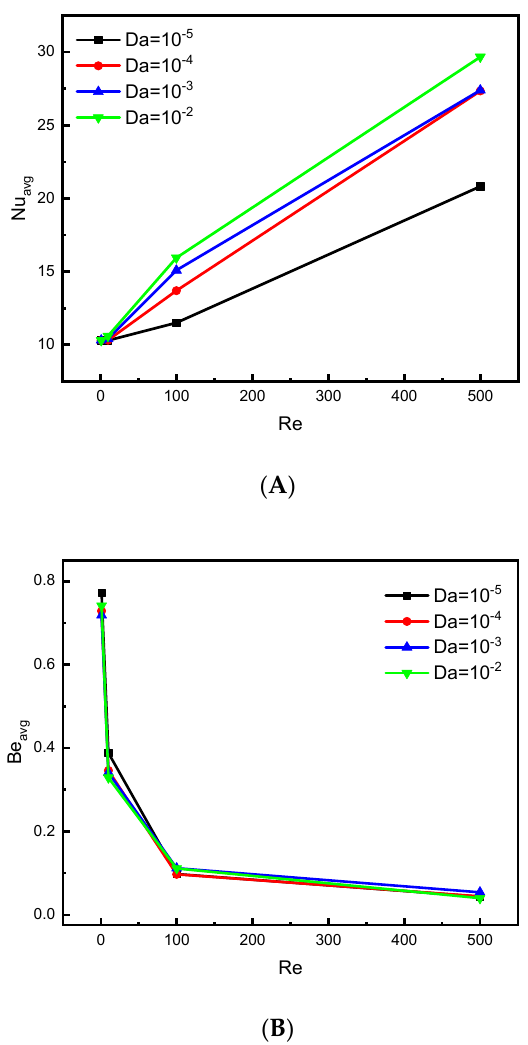
φ= Figure 8. Effect of Da on ( A ) Nu avg and ( B ) Be avg for 0.04 and Ha = 0. Figure 8. Effect of Da on ( A ) Nu avg and ( B ) Be avg for φ = 0.04 and Ha = 0. Figure 9A,B presents the influence of the number of lower wall zigzags on the average values of the Nusselt number (Nu) and Bejan number (Be) for Ha = 0 and Da = 10 − 2 . The number of zigzags in the bottom wall of the container changes the course of flow, which affects the heat transfer and total entropy generation. Figure 9A proves that the Reynolds number positively affects the Nusselt number for all values of the number of zigzags. In addition, when the value of the Reynolds number is less than 100, meaning that the buoyancy-driven flow is dominant, the values of the Nusselt number are the largest for N = 4. On the other hand, when the Re value is greater than 100, i.e., the forced convection is dominant, the values of the Nusselt number become greater for N = 2, whereas the mean value of the Bejan number is significant when N =